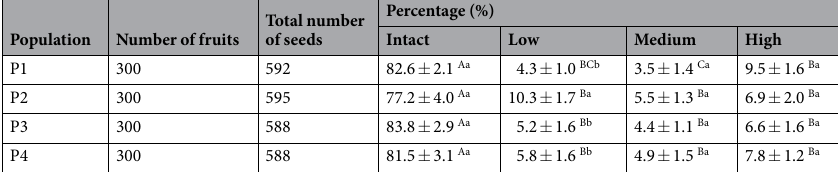
Table 1. Percentage (mean ± se) of seeds damaged by insect predation in the four study populations of Astragalus lehmannianus . Different uppercase letters indicate significant differences within the same populations and different lowercase letters significant differences in the four populations ( P <